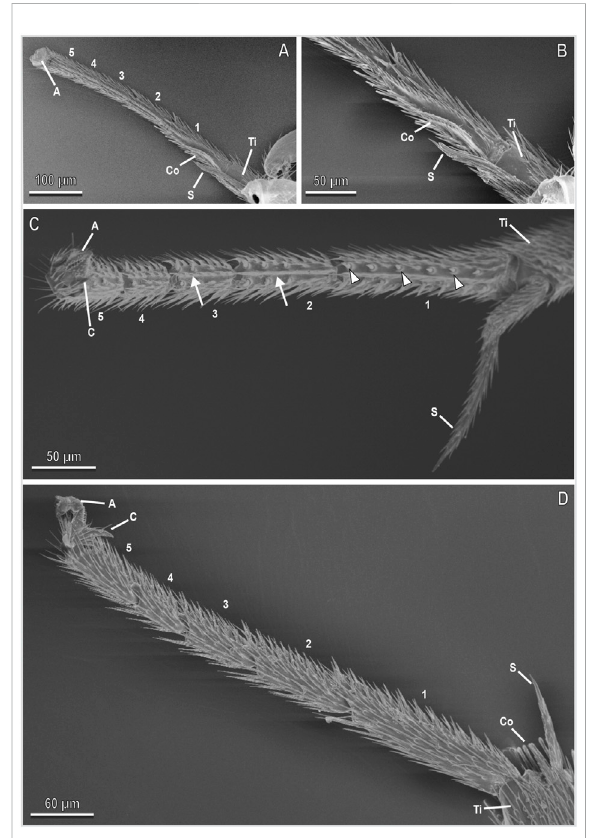
FIGURE 2 Tarsi of the male of A. bifasciatus in cryo-SEM. Forelegs (A,B) , midleg (C) , and hindlegs (D) showing the fi vetarsomeres(1 – 5), the pretarsal claws (C) , and arolium (A) , the tibia (Ti) with the tibial spur (S), the cleaning structures with the comb (Co). Note the setae (arrowheads) and microtrichia (arrows) along the inner side of the